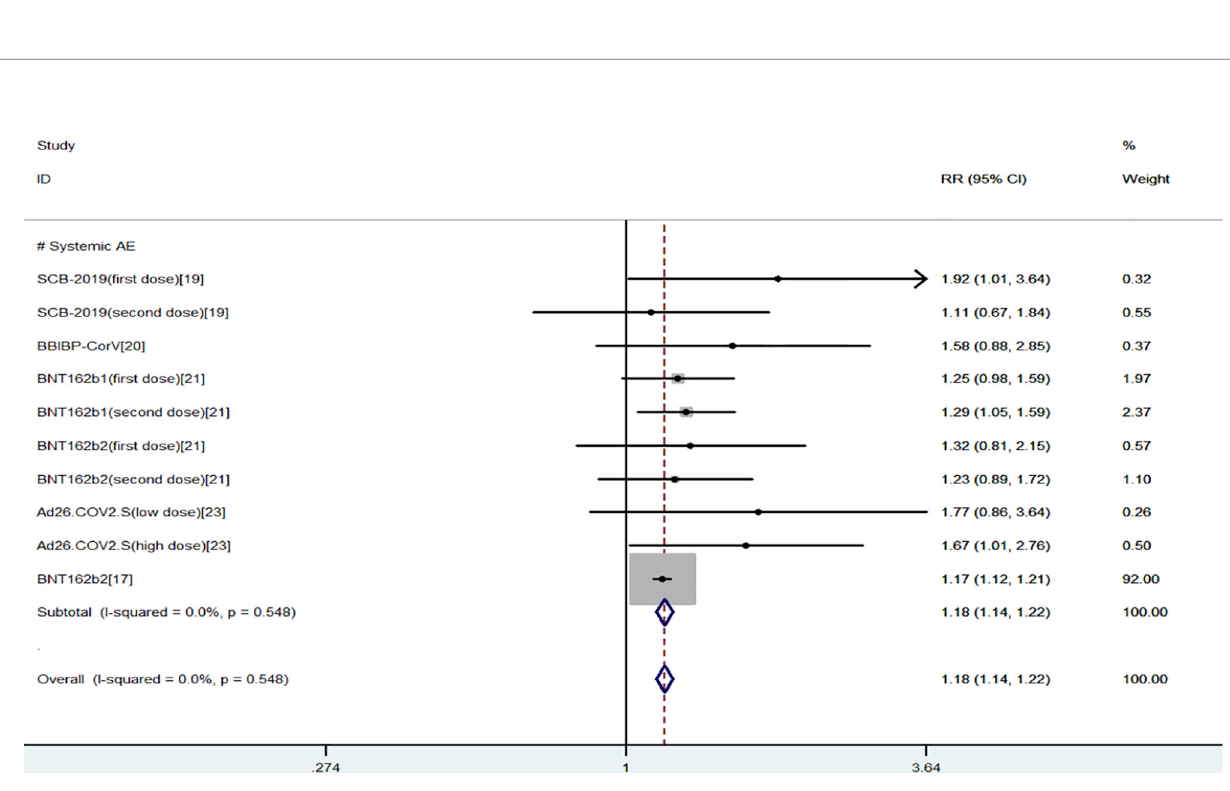
Frontiers in Immunology |